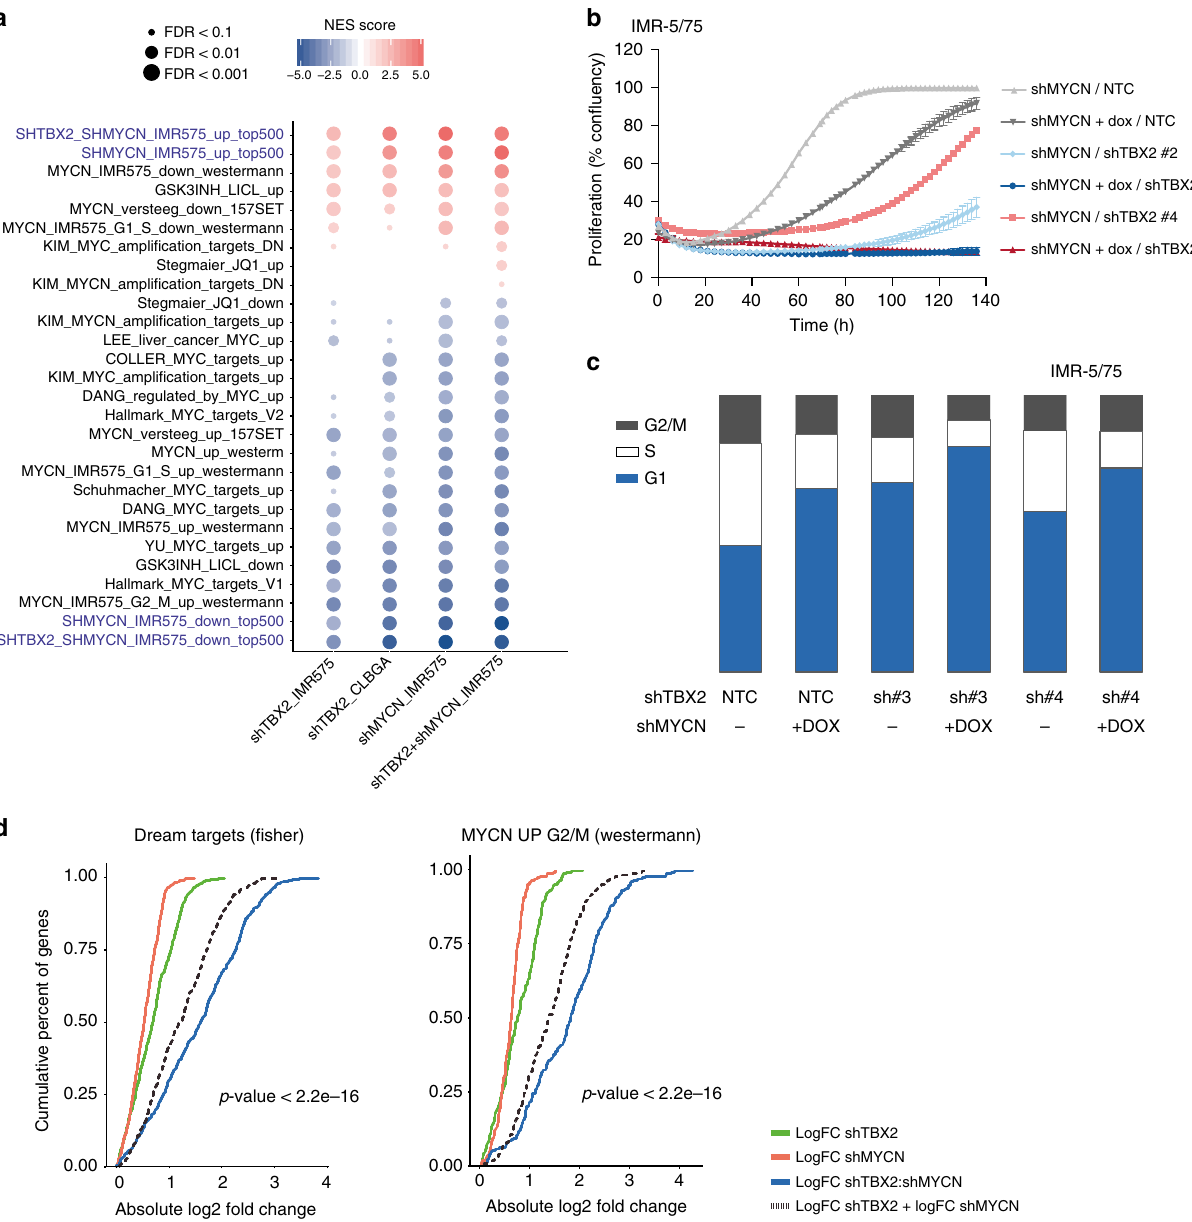
Fig. 6 Combined TBX2-MYCN signaling targets the FOXM1/E2F network. a Heatmap showing GSEA enrichment scores (with FDR < 0.1) for an in house compiled gene set collection containing all MYC target genesets from the “ Hallmark V5.1 ” catalog (MsigDB) as well as publically available MYC(N) activity or target signatures upon knockdown of TBX2 in IMR-5/75, CLB-GA, knockdown of MYCN in IMR-5/75 or the combination of TBX2 and MYCN knockdown in IMR-5/75. Size of the circles indicate FDR value and the color indicates the NES score. Positive values (red) point at enrichment among the upregulated genes while negative values (blue) indicate enrichment among the downregulated genes. b Synergistic reduction of cell proliferation upon combined knockdown of MYCN and TBX2 in the IMR-5/75 cell line measured with time-lapse microscopy (every 2 – 3 h) using the IncuCyte device (one out of three biological replicates is shown). Error bars represent the s.d. of fi ve technical replicates. Bliss independence score was used to calculate potential synergism at 120 h for both the sh TBX2 #2 and #4 compared with the double MYCN and TBX2 knockdown. Excess over bliss score for sh TBX2 #2 is 0.092, excess over bliss score for sh TBX2 #4 is 0.342. Excess over Bliss scores > 0 indicates synergy, < 0 indicates antagonism. c Combined TBX2 and MYCN knockdown in the IMR-5/75 cell line results in an enforced G1-cell phase arrest with almost no cells in S-phase or G2/M phase left (one replicate out of 3 shown). d Cumulative distribution plot of the absolute log fold changes of sh TBX2 , sh MYCN or sh TBX2 :sh MYCN up- and downregulated genes. Dashed line represents the sum of the log fold changes of the sh TBX2 and sh MYCN condition for the respective genes in the geneset. The difference between the blue line and the dashed line indicates synergism effect on logFC for the genes in the genesets implicated in cell cycle and MYCN regulation (two-sided paired t- test: p < 2.2e −